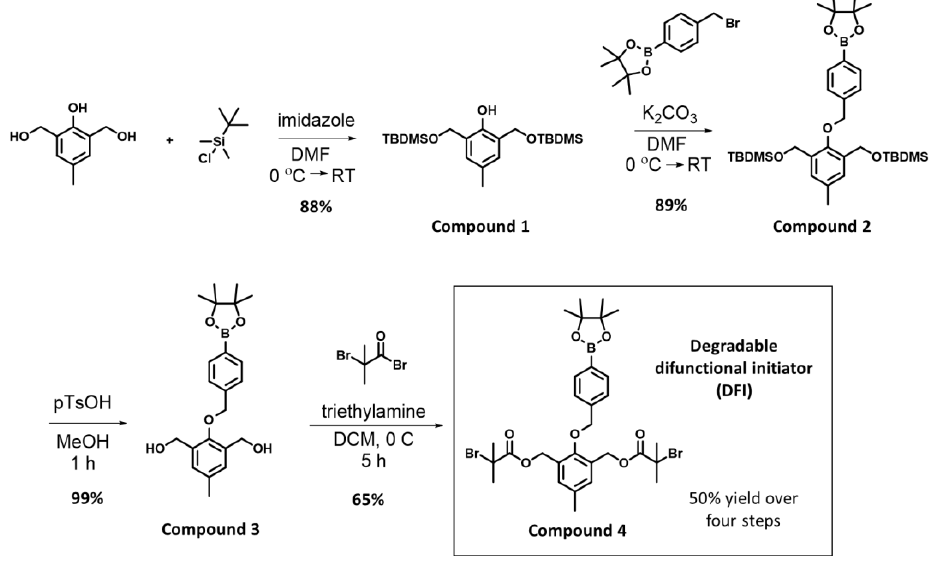
Figure 1. Synthesis of the degradable difunctional initiator (DFI) over four